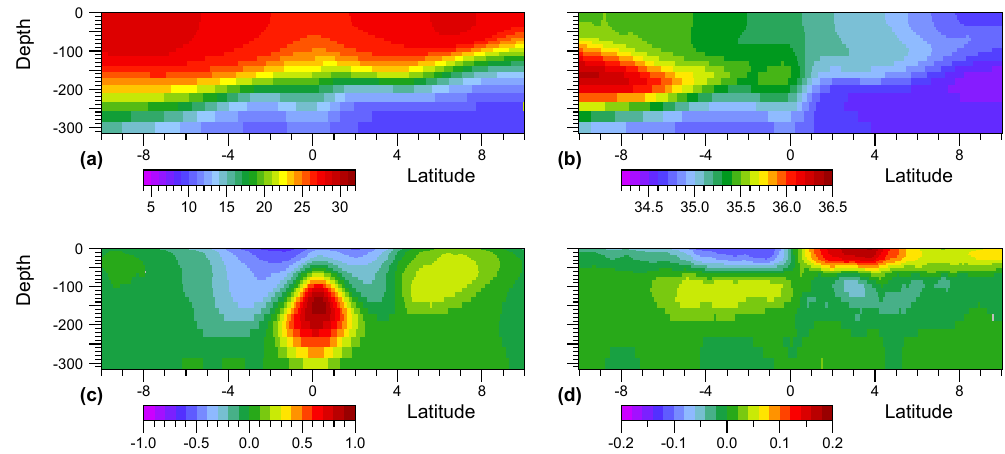
Figure 2. North–south sections at 200 ◦ E (160 ◦ W) of the average values during 1981 of (a) temperature ( ◦ C), (b) salinity, and (c) east and (d) north components of velocity (ms − 1 ).